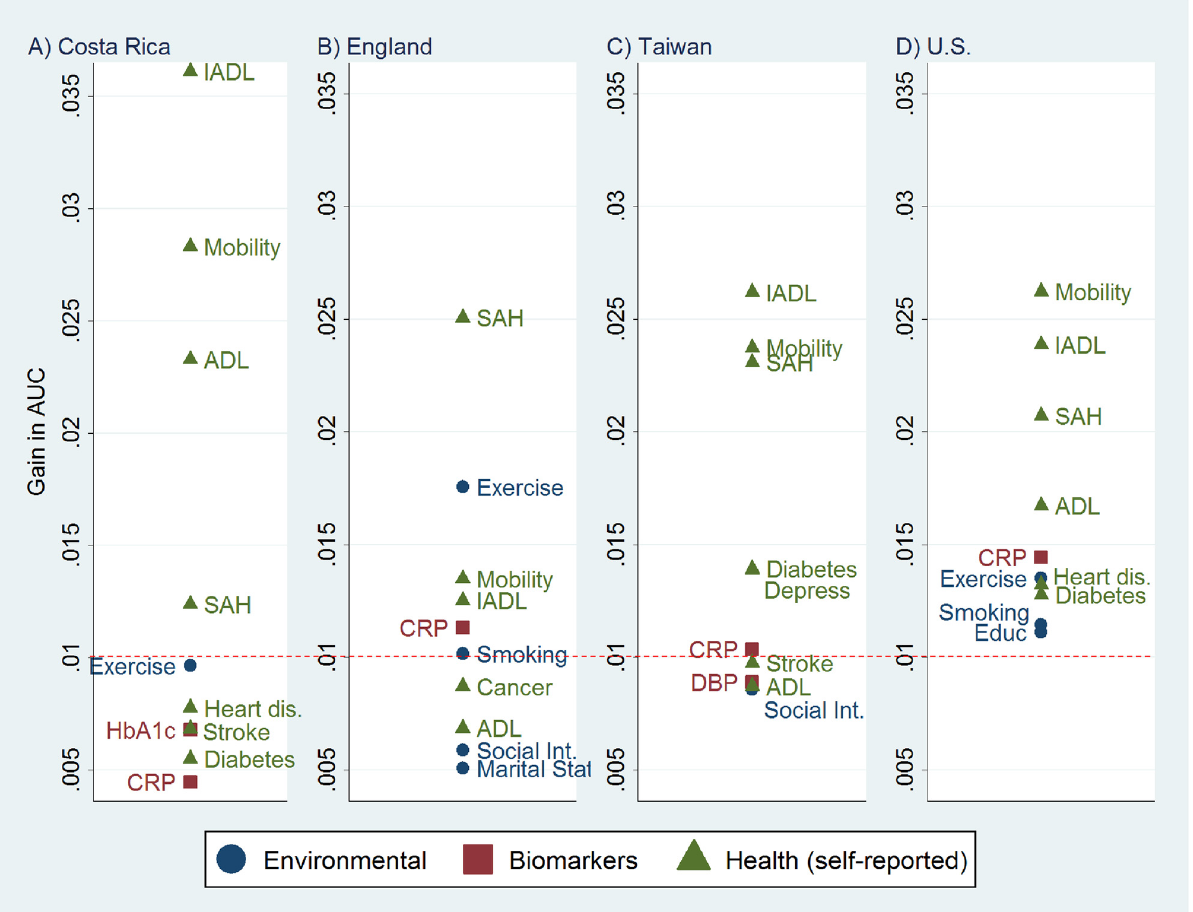
Fig 1. Top Ten Predictors (out of 25 variables available in all four datasets) of Five-Year Mortality After Adjustment for Age and Sex, Ranked by the Gain in AUC, A) Costa Rica, B) England, C) Taiwan, and D) the U.S. Abbreviations: ADL, Activities of daily living; AUC, Area under the receiver operating characteristic curve; CRP, C-reactive protein; Depress, Depressive Symptoms; Educ, Educational attainment; HbA1c, Glycosylated hemoglobin; Heart dis., Heart disease; IADL, Instrumental Activities of Daily Living; SAH, Self-assessed health status, Social Int., Social integration. a The values for diabetes and depressive symptoms in Taiwan are too close to be distinguishable.